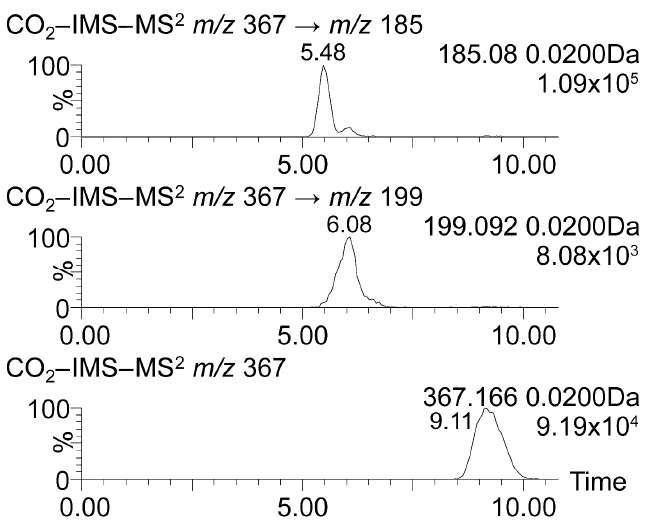
Figure 7 Figure 7. N 2 -driftgrams of precursor and major product ions originating from the m / z 367 ion. The top panel shows m / z 185 (C 9 H 13 O 4 - ), the middle panel shows m / z 199 (C 10 H 15 O 4 - ), and the bottom panel shows m / z 367 (C 19 H 27 O 7- ). The time axis is in milliseconds. Table 2 summarises the theoretically calculated Ω N2 values of cis -pinic acid and 10- hydroxy- cis -pinonic acid, and measured Ω N2 values of m / z 185 and m / z 199 product ions from N 2 -IMS-TOFMS 2 experiment for the m / z 367 ion.